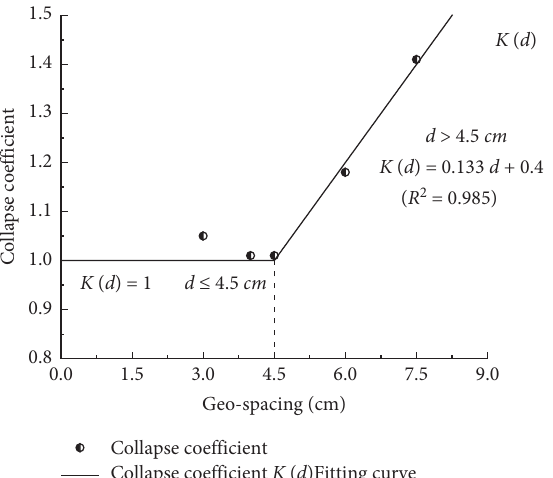
Figure 12: Fitting diagrams of collapse coefficient K ( d ) .